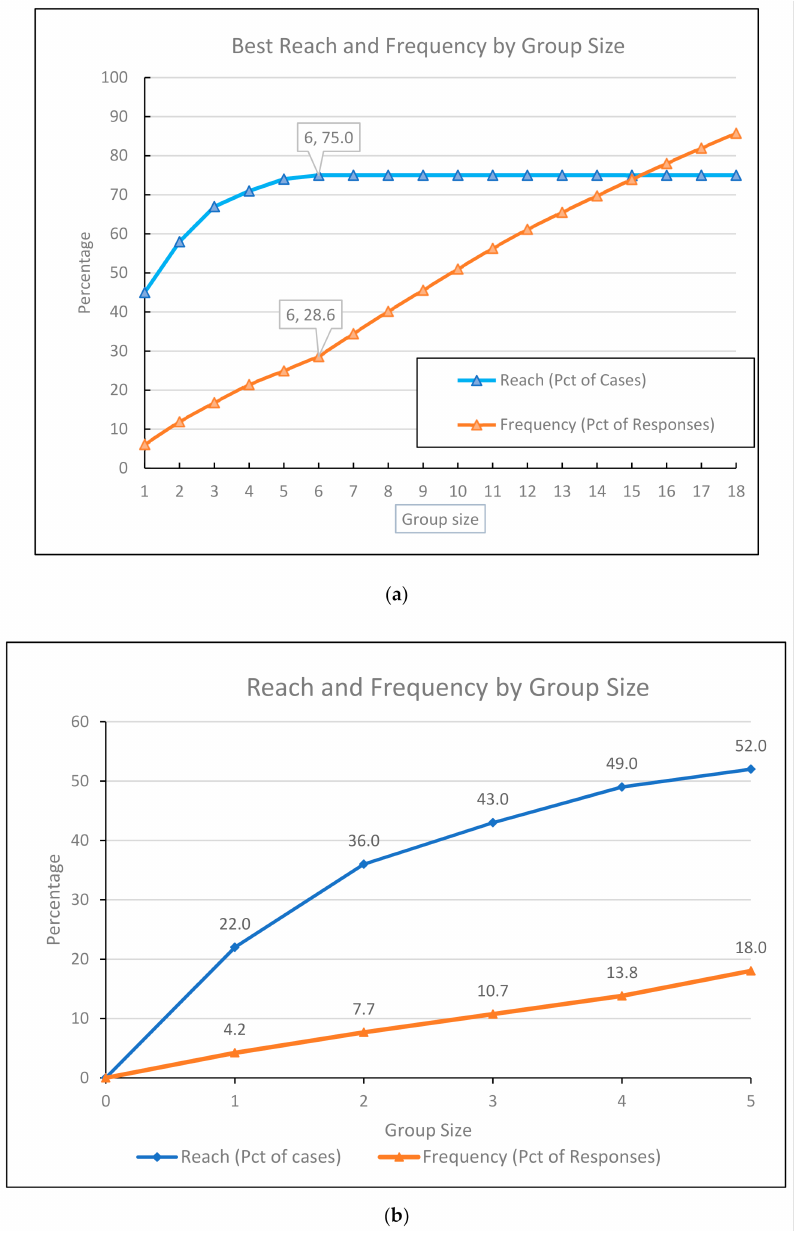
Figure 1. ( a ) Best reach and frequency by group size-18 molecular components. ( b ) Best reach and frequency by group size–5 molecular